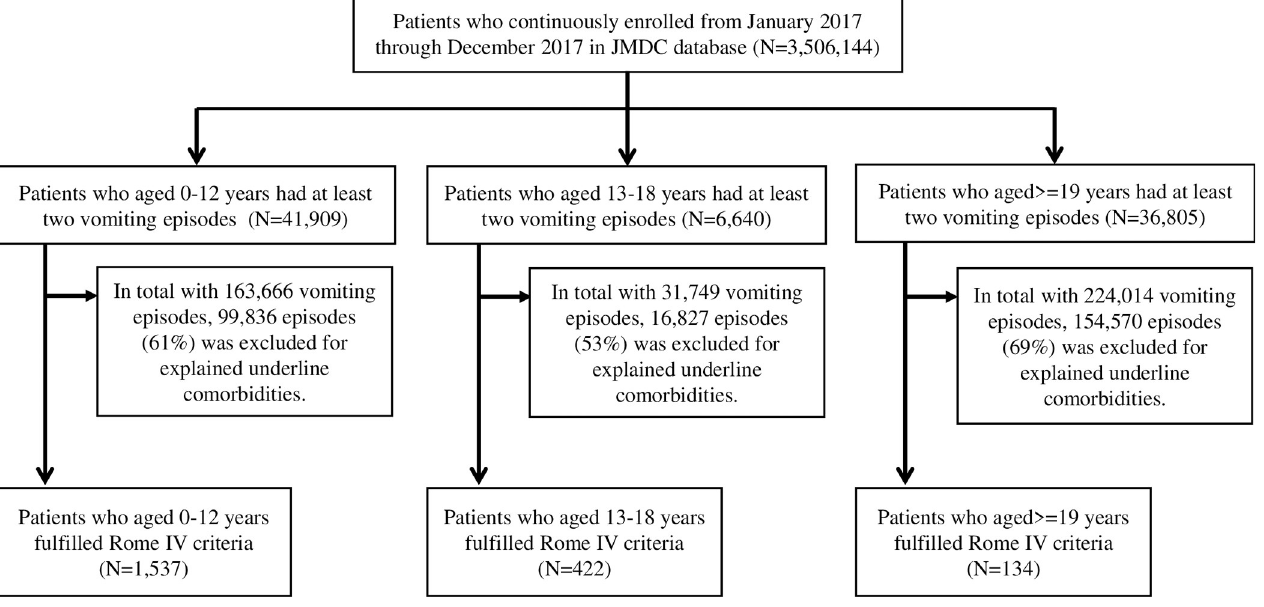
Fig 1. Flow chart of the study population and identified CVS